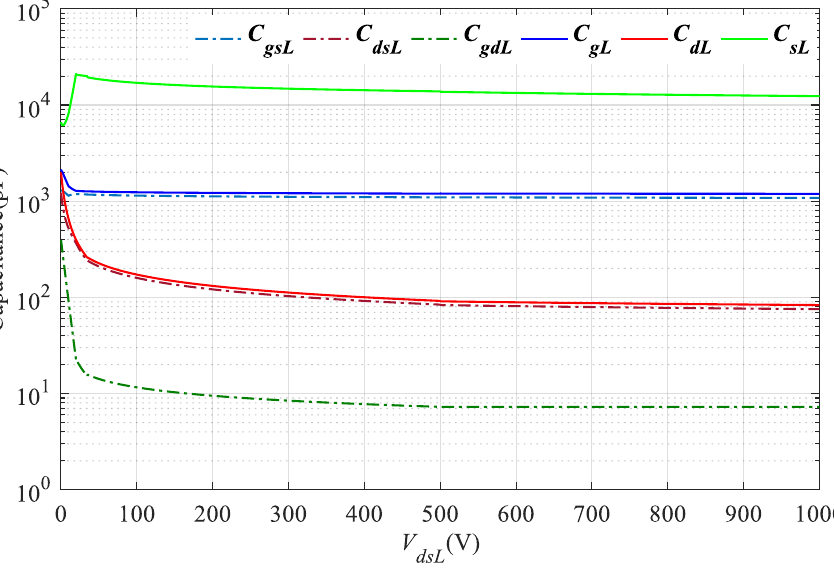
Figure 13. Comparison between the equivalent capacitances and the interelectrode capacitances. When V dsH drops to the on-state voltage V dsH_on (Stage 4), although Q H enters the ohmic region, V dsL of Q L will continue to oscillate after it rises to V DD due to the RLC characteristic of the power loop. The ideal voltage division given in [24] cannot be